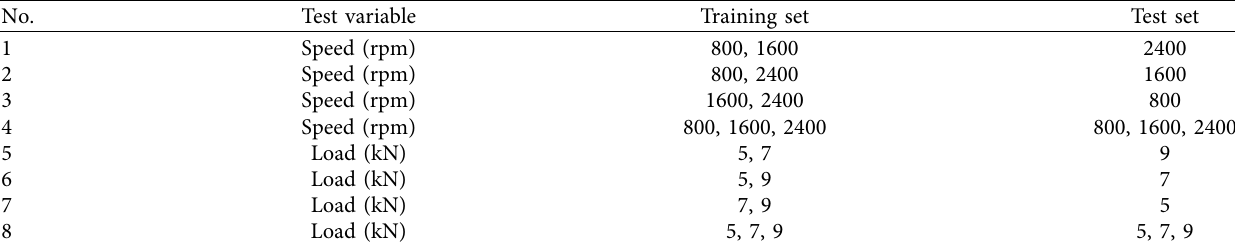
Table 2: Eight basic diagnostic